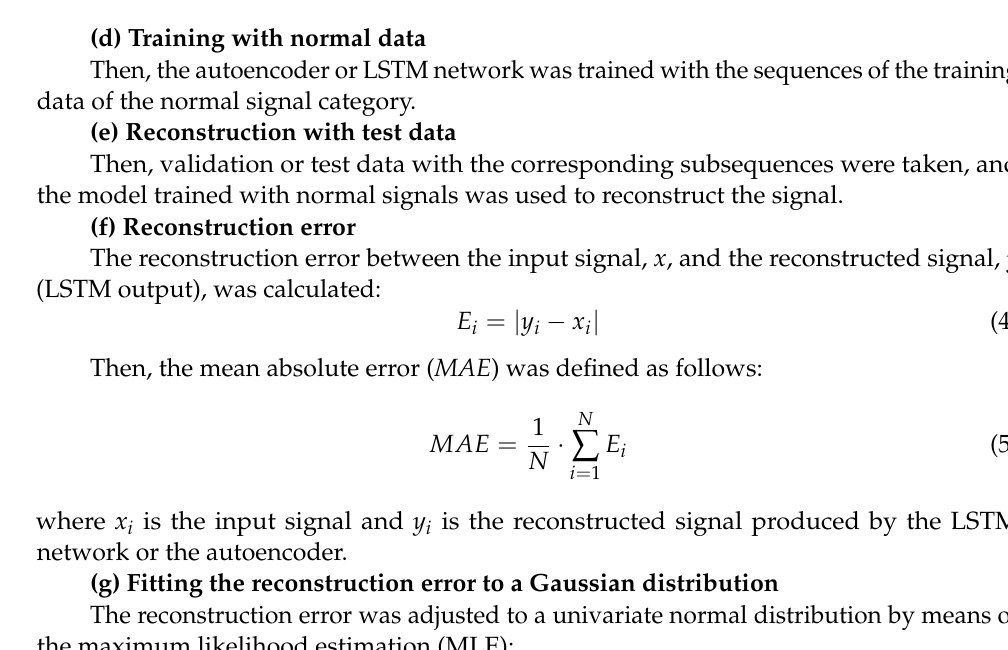
Figure 4. Creation of the subsequence matrix, X , from the contraction time series, x